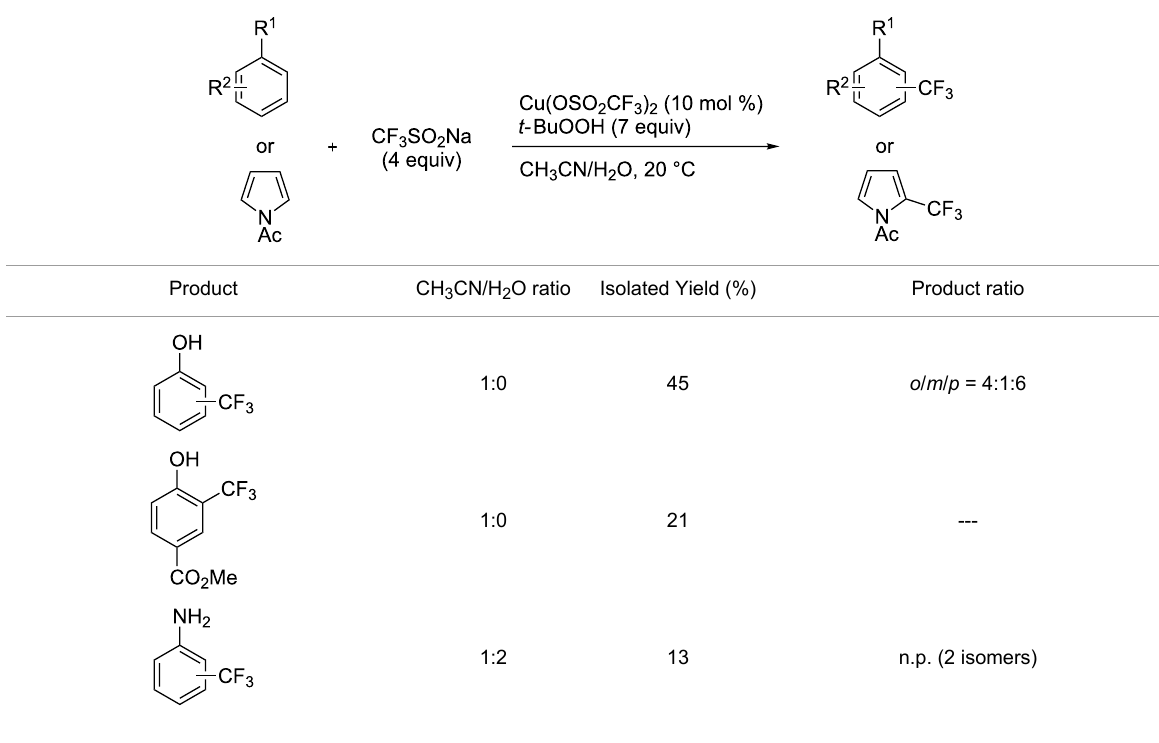
Table 19: Cu-catalyzed trifluoromethylation with Langlois’s sodium trifluoromethanesulfinate as CF 3 radical source